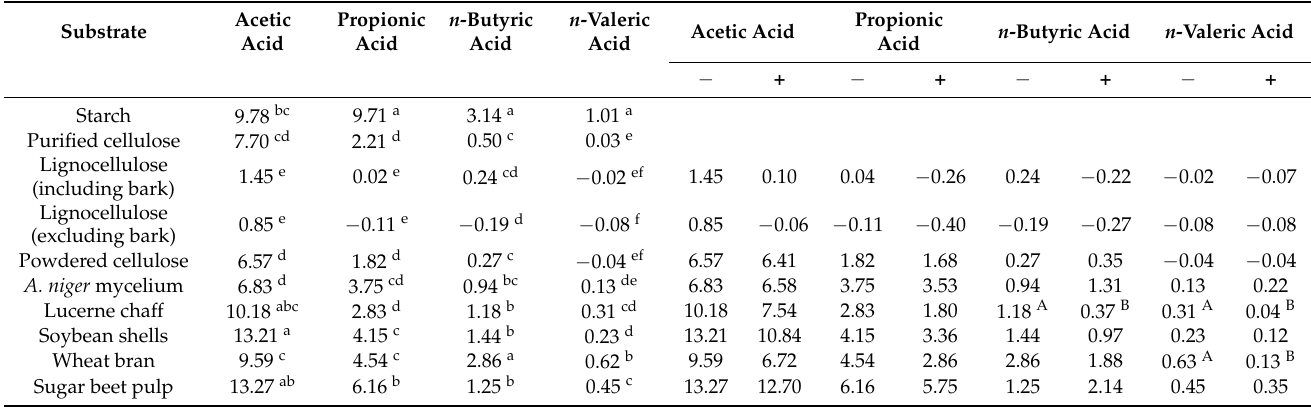
Standard errors ranged between 0.0144 and 1.40 mmol/L. a–f Within a column, different superscripts indicate difference among the not pre-digested substrates ( p < 0.05). A,B Within a row, different upper-case superscripts indicate difference between not pre-digested ( − ) and pre-digested (+) materials ( p <